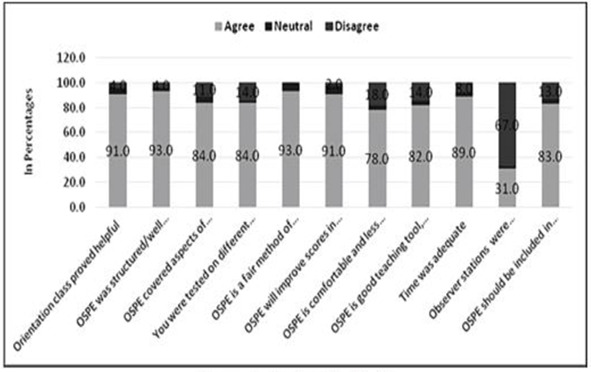
 Student feedback